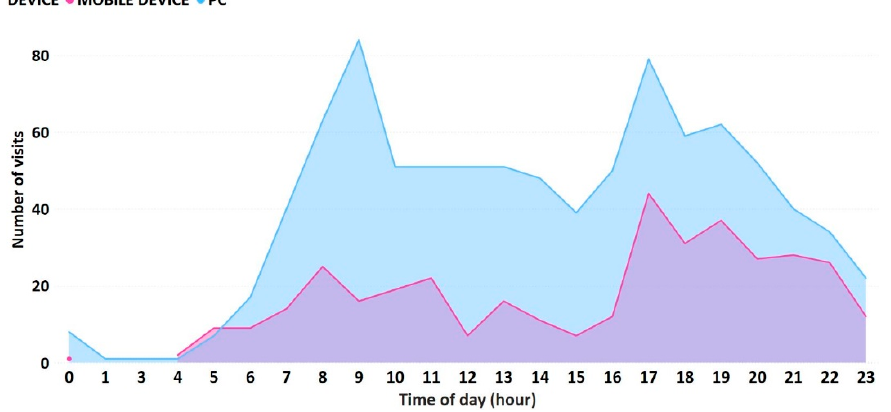
Figure 10. Total number of portal visits by time of day and device.